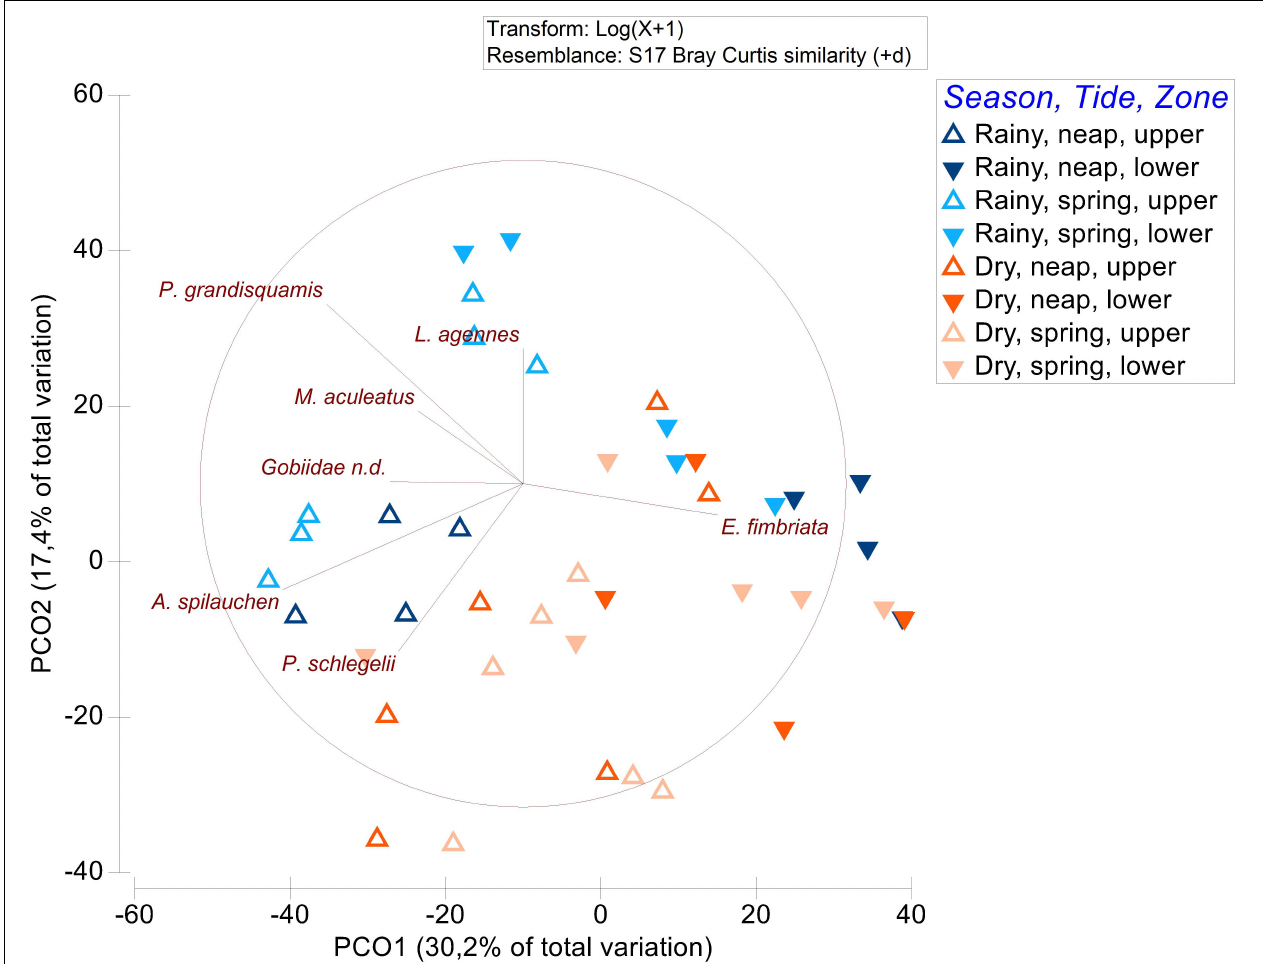
FIGURE 6 | Principal coordinates ordination (PCO) plot of the fish assemblages data with differentiated points according to season (rainy and dry), tide (spring and neap), and mangrove zone (upper and lower). Vectors inside the circles represent the species that characterize the distribution of the points.